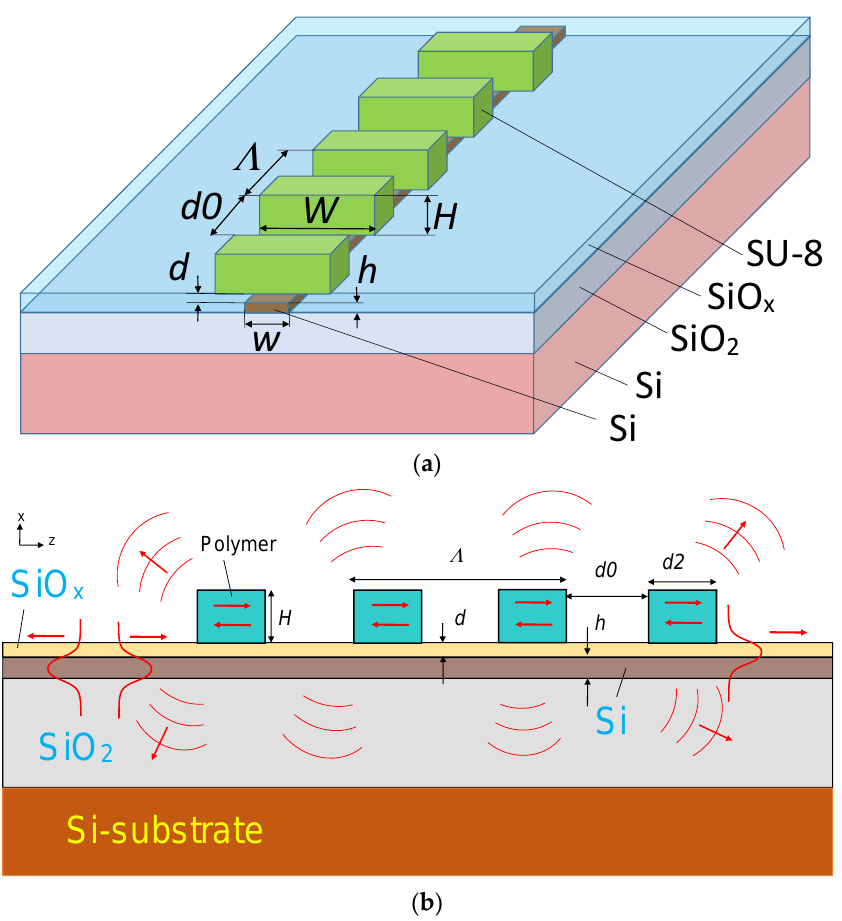
Figure 1. Structure design for modeling of guided wave propagation in the silicon waveguide, which is evanescently coupled to the segmented grating. The fundamental TE 0 mode starts at Z = 0 and propagates under the periodic segmented grating formed by multiple dielectric strips. ( a ) 3D view; ( b ) 2D view.